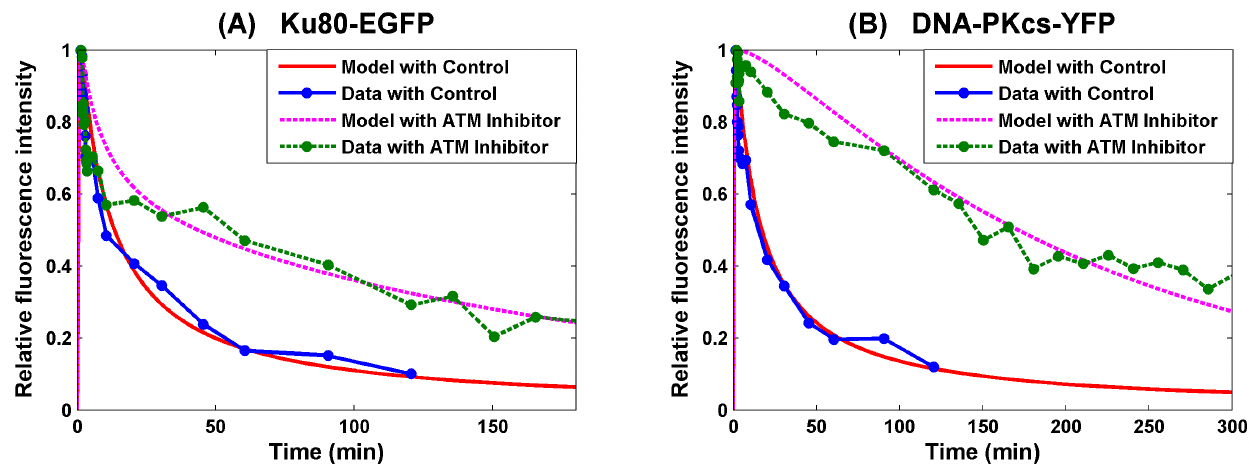
Figure 3. SF Model - Formation and loss of Ku80-EGFP and DNA-PKcs-YFP at the DSB in the radiation stripes with ends processing following synapsis formation. Panel (A) is for Ku80-EGFP and panel (B) for DNA-PKcs-YFP. The lines with dots are experimental data from [1], and those without dots are numerical simulation of the model. The solid lines are represent calculated normalized fluorescence intensity of the respective fluorescently tagged proteins with control, and the dashed lines are with ATM inhibitor present.